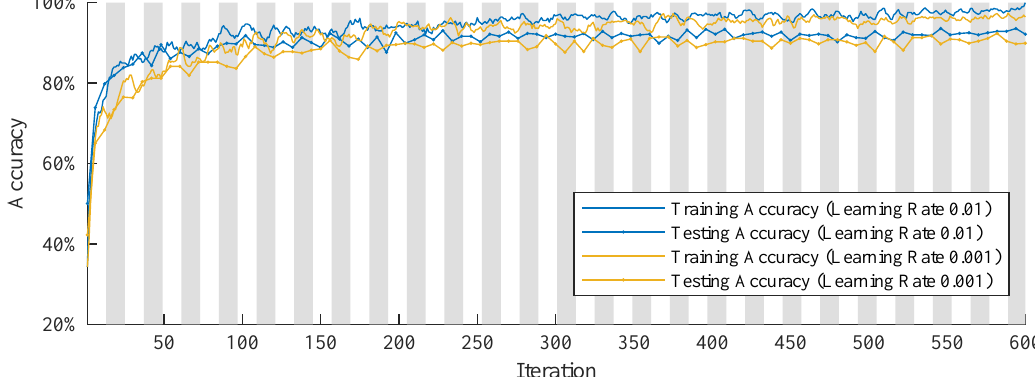
Figure 4. Training progress plot of the convolutional neural network with different learning